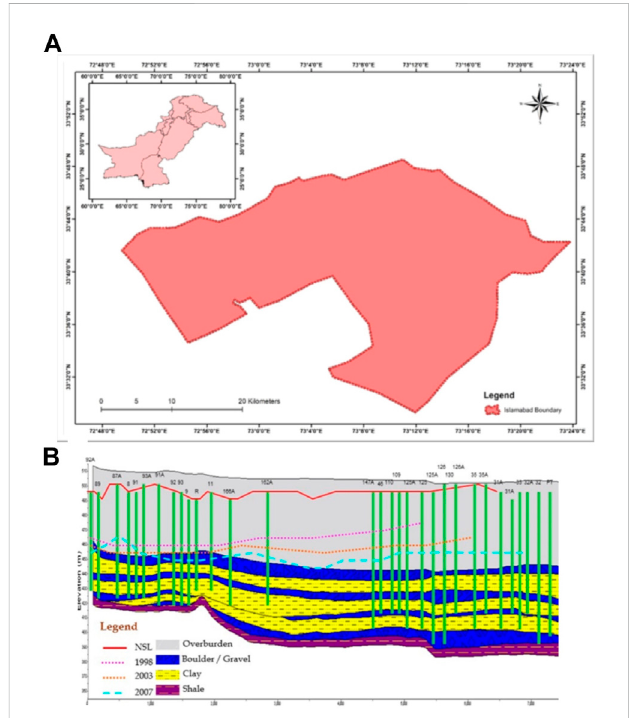
FIGURE 1 (A) Location map of the study area (Islamabad) (B) Image showing the sub-surface geology of the Rawalpindi and Islamabad area (Abbas et al.,